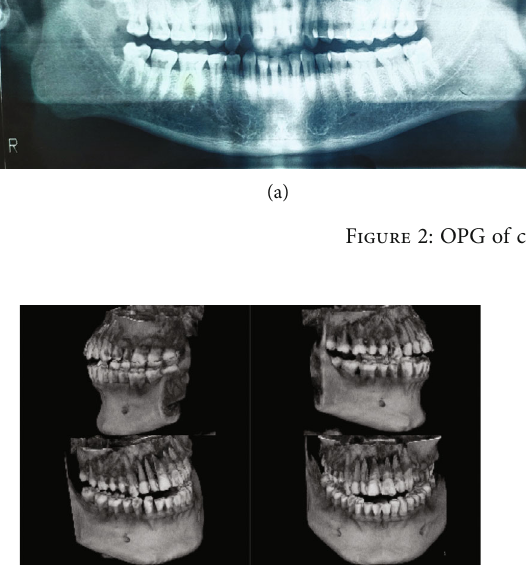
Figure 3: 3D CBCT view of case 1 showing resorption over the maxillary alveolus region on the right